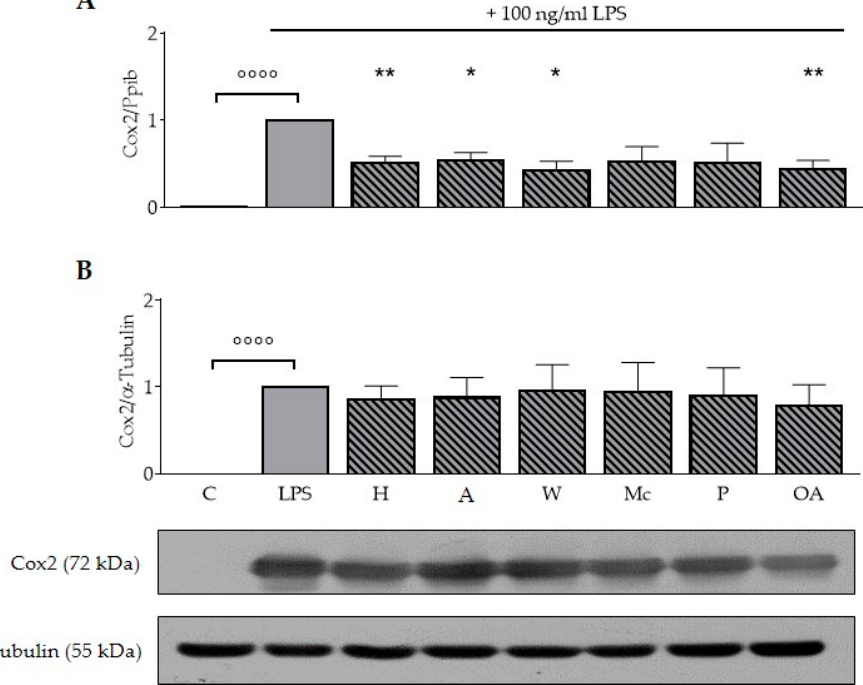
Figure 2. Oily nut extracts and oleic acid decrease lipopolysaccharide-induced expression of Cox2 expression in murine RAW264.7 macrophages. RAW264.7 macrophages were incubated as described